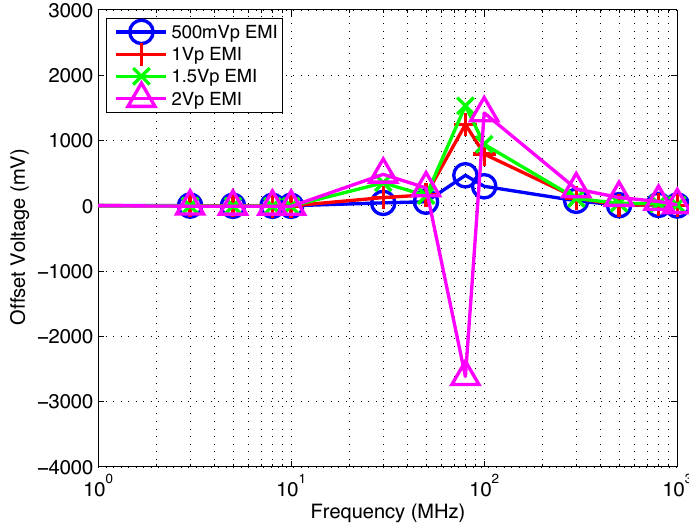
Figure 6. EMI induced offset in ICL7611: interferences coupled to the output